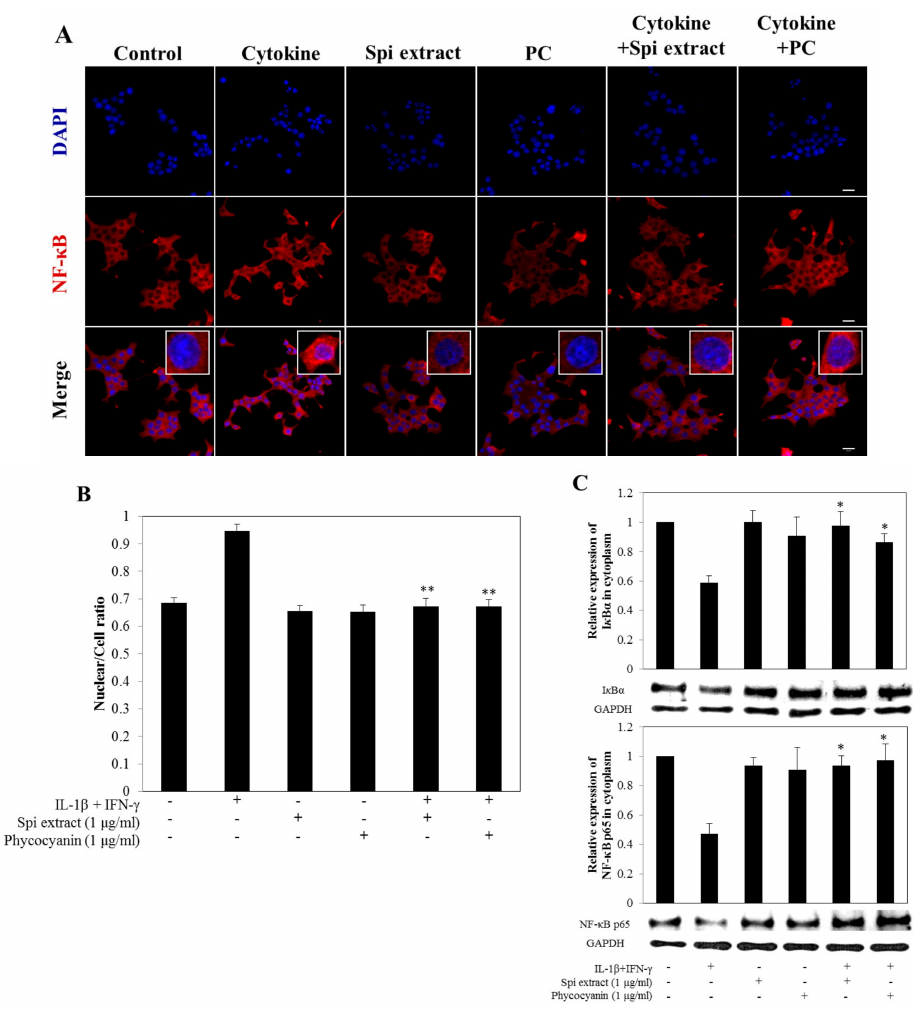
Figure 3. Spirulina extract inhibits IL-1 β - and IFN- γ -induced NF- κ B activity, translocation of p65 to the nucleus, and I κ B α degradation. RINm5F cells were co-treated with Spirulina (Spi) extract or PC, and IL-1 β and IFN- γ for 24 h. ( A ) NF- κ B activity was observed by confocal microscopy (magnification, 400 × ); ( B ) The relative intensity of NF- κ B activity was analyzed by confocal microscopy software; ( C ) Western blot analysis of I κ B and NF- κ B p65 in the cytoplasm fraction. The relative expression